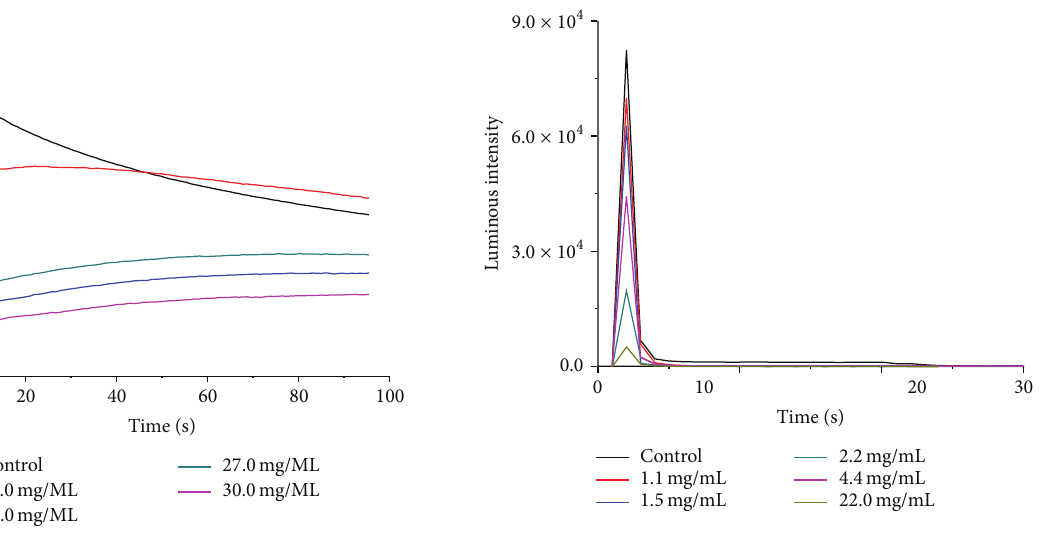
Figure 1: Inhibition of different concentrations of ophiurasaponin to hydroxyl: 20 mg/mL, 23 mg/mL, 25 mg/mL, 27 mg/mL, and 30 mg/mL.